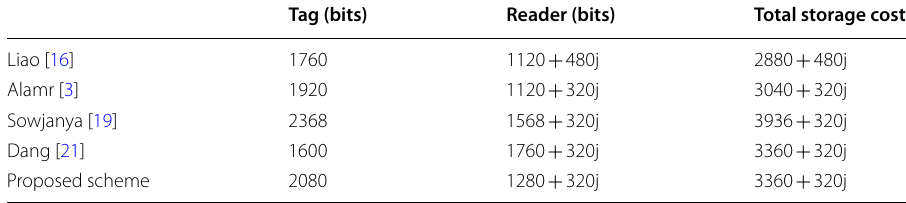
Table 12 Comparison of data storage cost among related protocols in authentication phase Tag (bits)